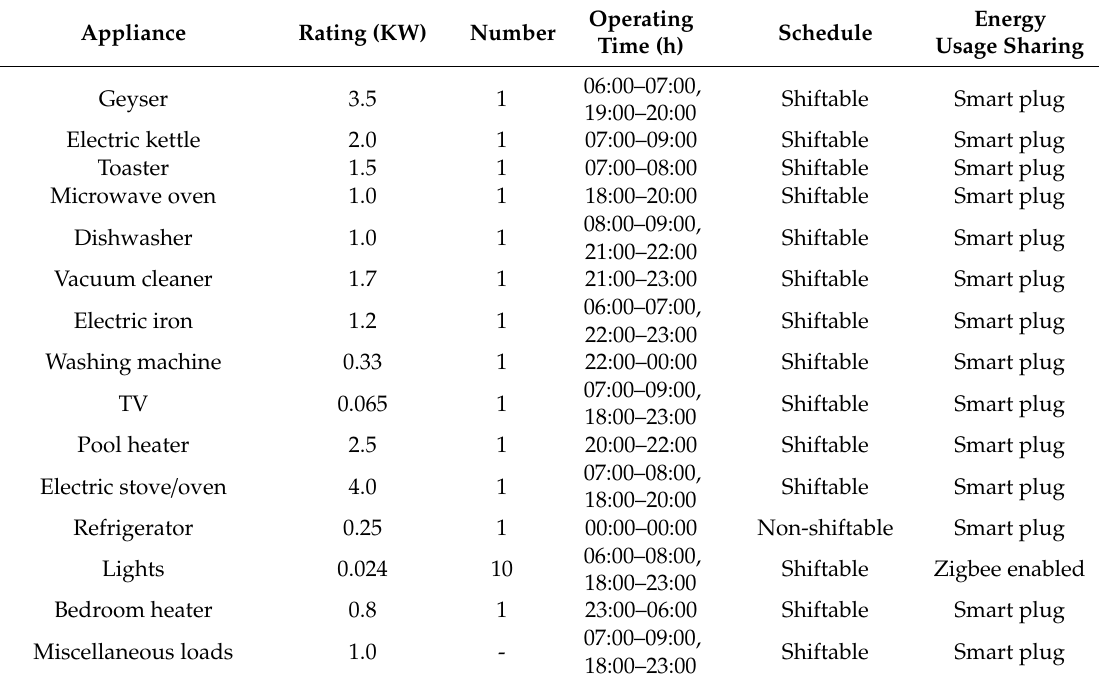
Table 1. Appliance schedule for apartment